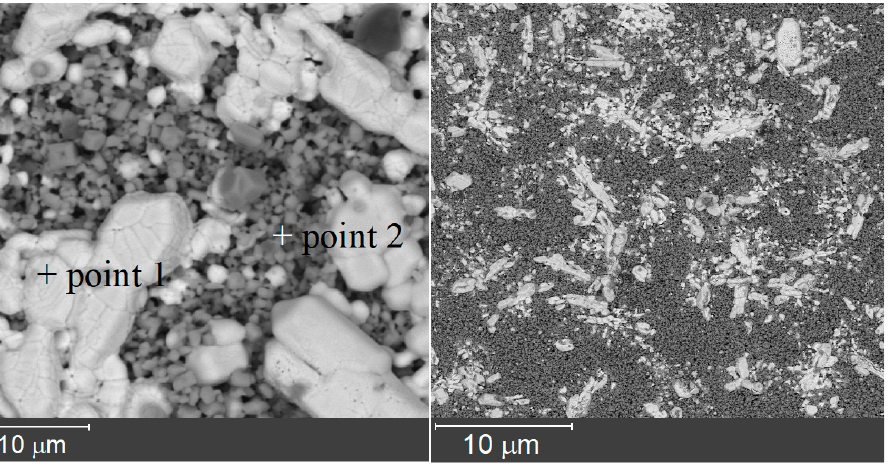
Figure 10. SEM images for the ceramic sample of Gd 1.90 Mg 0.10 Zr 2 O 6.95 , exposed for 48 h in LiCl–Li 2 O (4 mas.%)